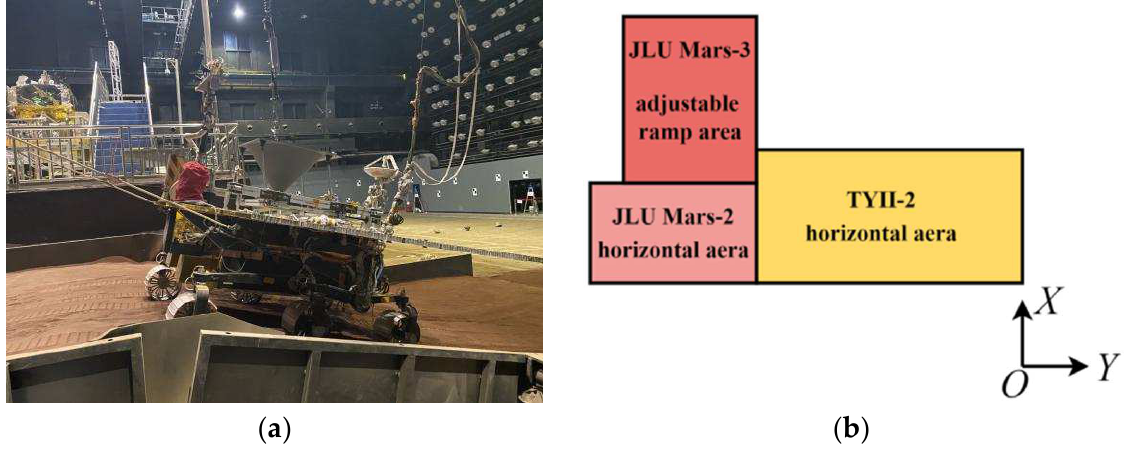
Figure 4. ( a ) The indoor test site of ground tests; ( b ) the distribution of simulated soil. Table 1. The mechanical parameters of TYII-2 and JLU Mars-2.